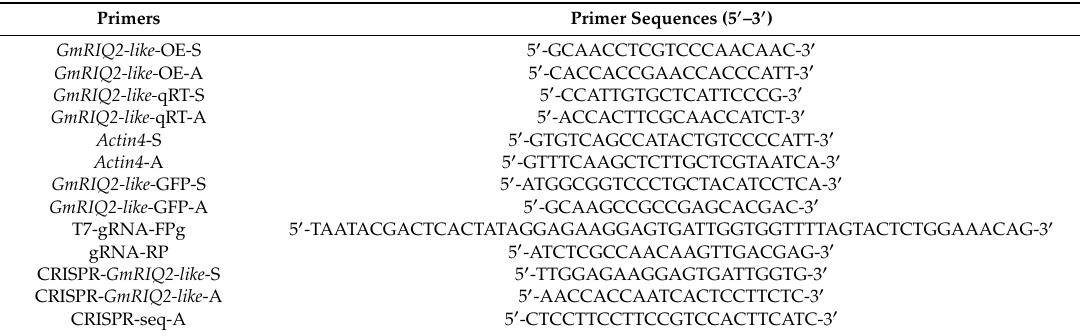
Table 1. List of primers used in this